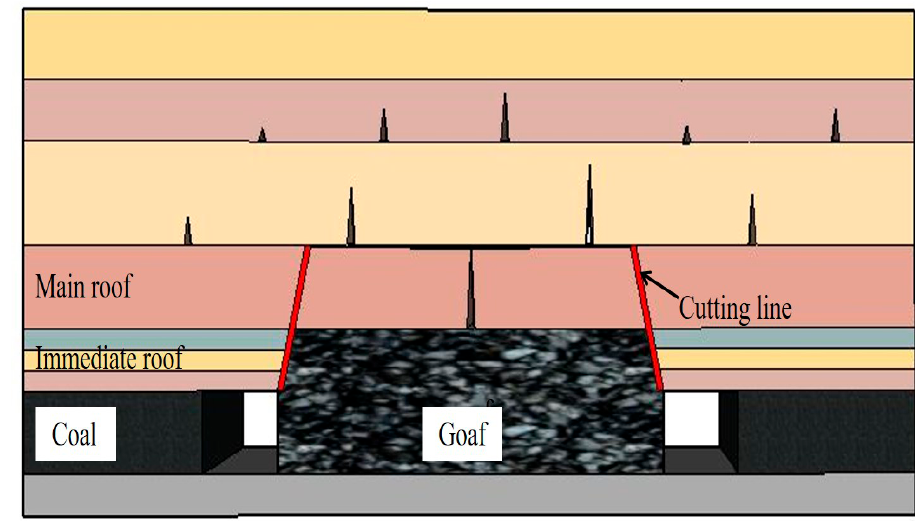
Figure 19. Overburden movement status in the FRME.